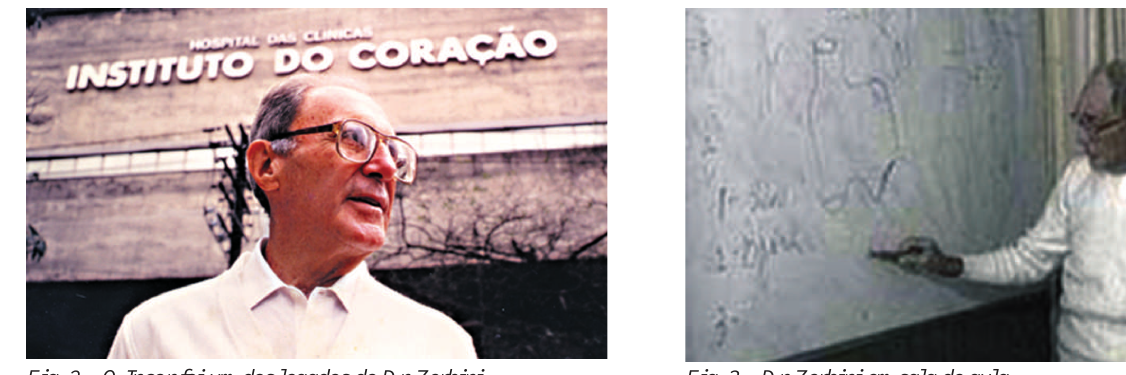
Fig. 3 – Dr. Zerbini em sala de aula Fig. 2 – O Incor foi um dos legados do Dr. Zerbini